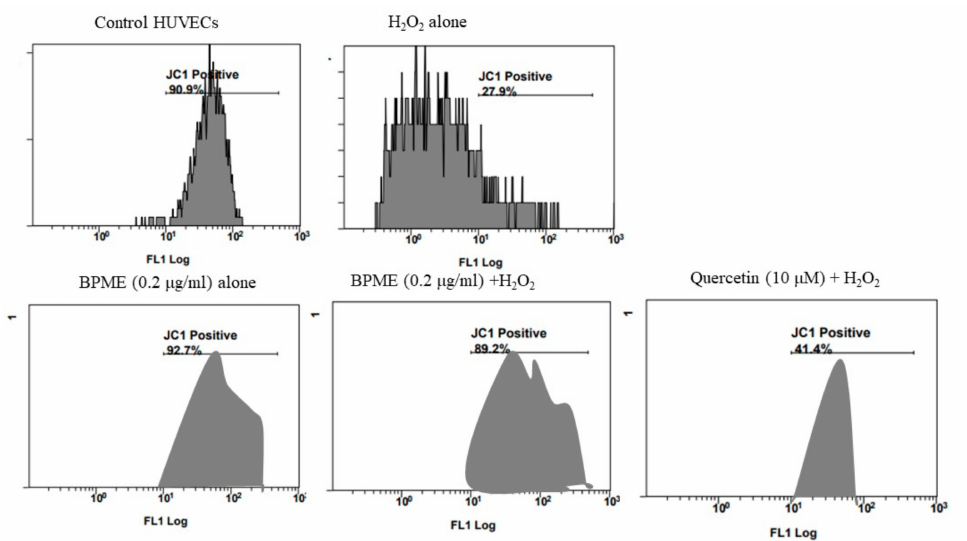
Figure 6. Flow cytometry-based analysis of mitochondrial membrane capacity using JC-1 ( ∆ ψ m , BD Mito Scan) in normal and H 2 O 2 -induced oxidative-stressed HUVECs treated with 0.2 µ g/mL of BPME. Untreated cells were considered a negative control, whereas H 2 O 2 (10 mM) was added for positive control.